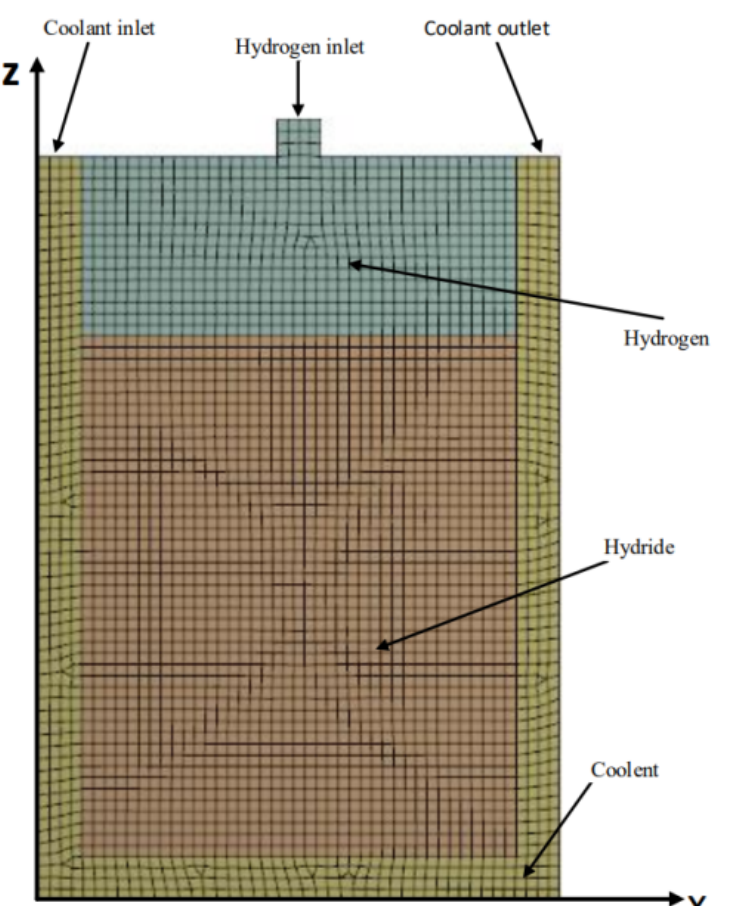
Figure 4. A hydrogen storage tank grid model with cooling bath.